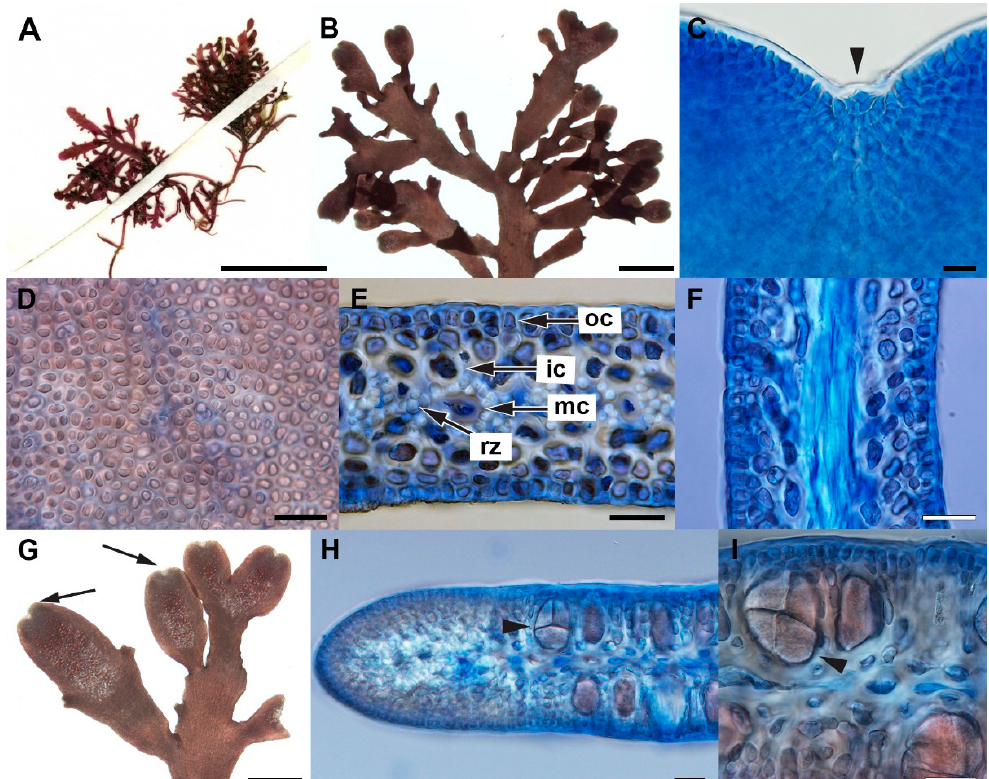
Figure 6. Gelidium usmanghanii from southern Madagascar. ( A ) Habit; ( B ) branchlets arising from the margin of erect axis and second-order branches; ( C ) retuse apex (arrowhead); ( D ) irregularly arranged outermost cortical cells; ( E ) transverse section through a middle part of erect axis showing outermost cortical cells (oc), inner cortical cells (ic), internal rhizoidal filaments (rz), and medullary cells (mc); ( F ) longitudinal section of erect axis showing medullar and cortical layer; ( G ) tetrasporangial sori having retuse apices (arrows) with sterile margin; ( H ) transverse section through the tetrasporangial sorus, with a wide sterile margin, showing decussately divided tetrasporangia (arrowhead); ( I ) transverse section through the tetrasporangial sorus showing cruciately divided tetrasporangia arising from inner cortex (arrowhead). Scale bars: 1 cm ( A ), 1 mm ( B ), 500 μ m ( G ), 20 μ m ( D – F , H , I ), and 10 μ m ( C ).